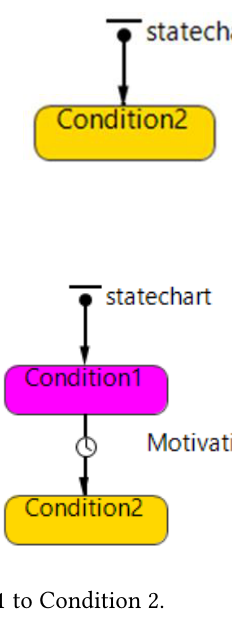
Figure 7: The transition of an agent from Condition 1 to Condition